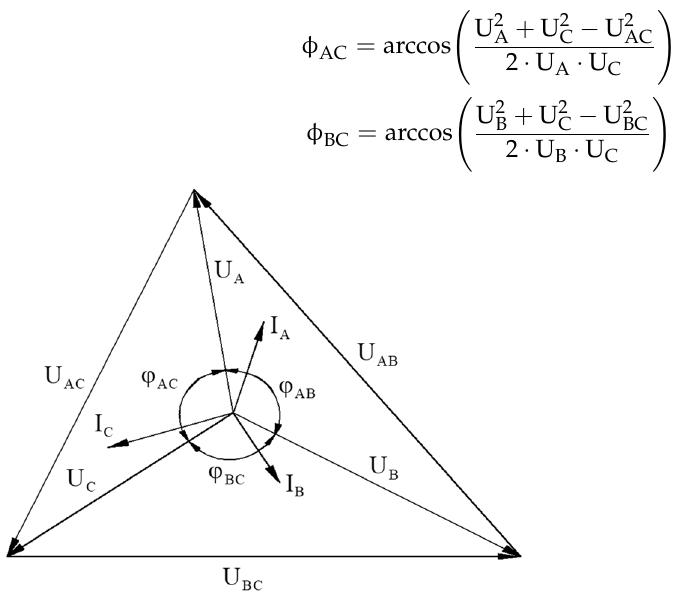
Figure 1. Vector diagram of currents and voltages at asymmetry (own elaboration based on